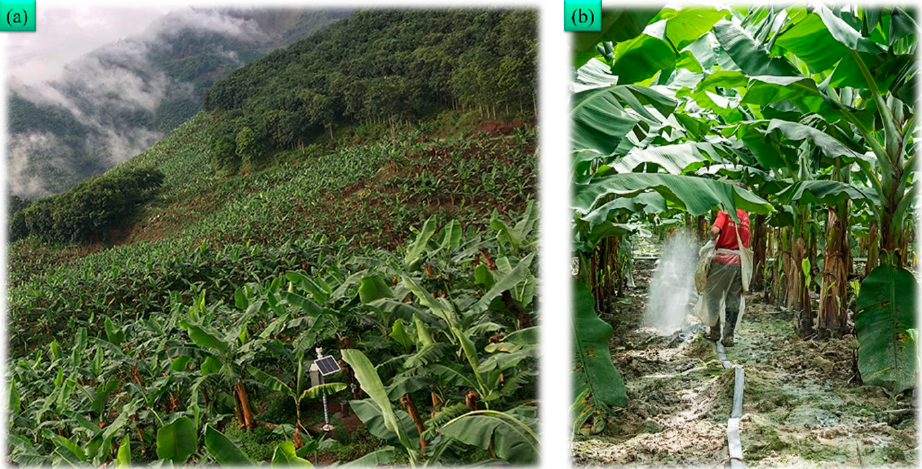
Figure 2. Banana orchards and their growing patterns. ( a ) Appearance of a banana orchard located in a hilly mountainous area, ( b ) The interior view of a banana plantation in the plains.